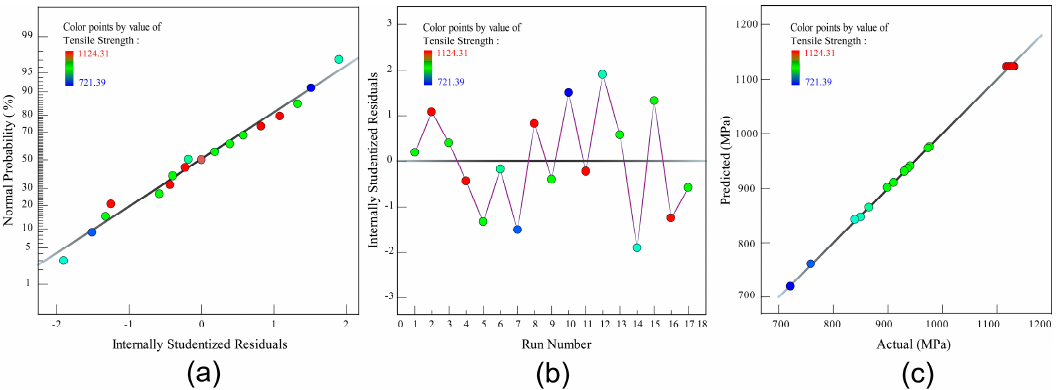
Figure 3. Residual analysis results. ( a ) Residuals normal plot of tensile strength model; ( b ) Residual versus run plot of tensile strength model; ( c ) Predicted versus actual plot of tensile strength model.